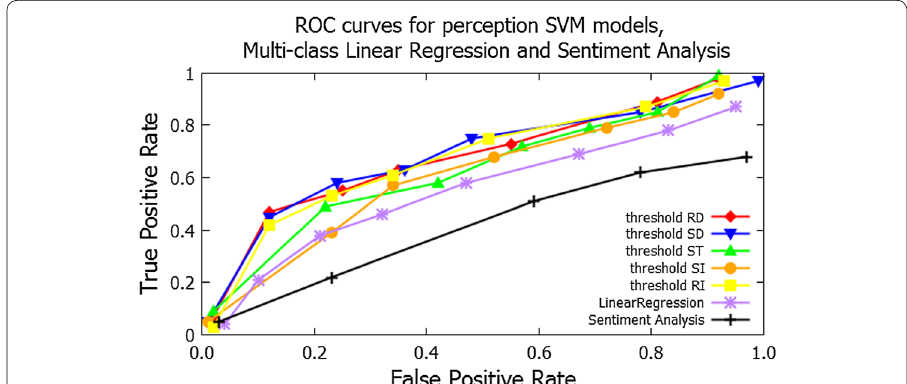
Fig. 5 DERIV brand perception SVM, Logistic Linear Regression and Sentiment analysis ROC curve